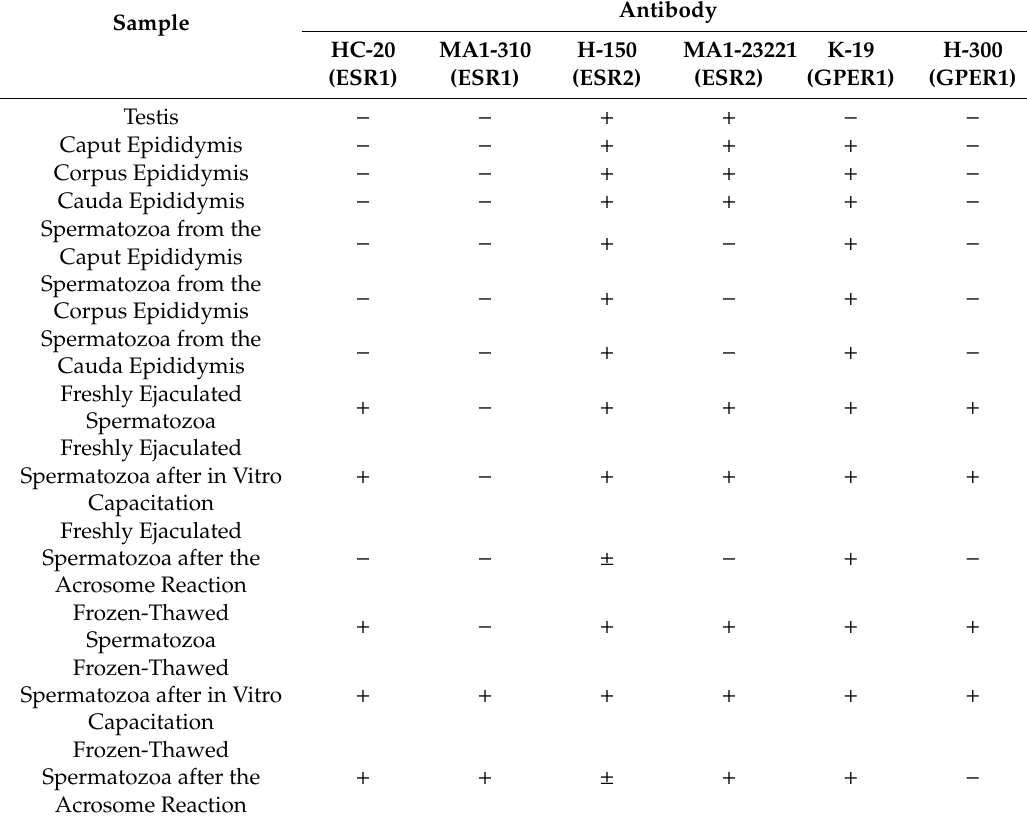
Table 1. Immunofluorescent detection of ERs in bull reproductive tissues and spermatozoa with all used anti-ER